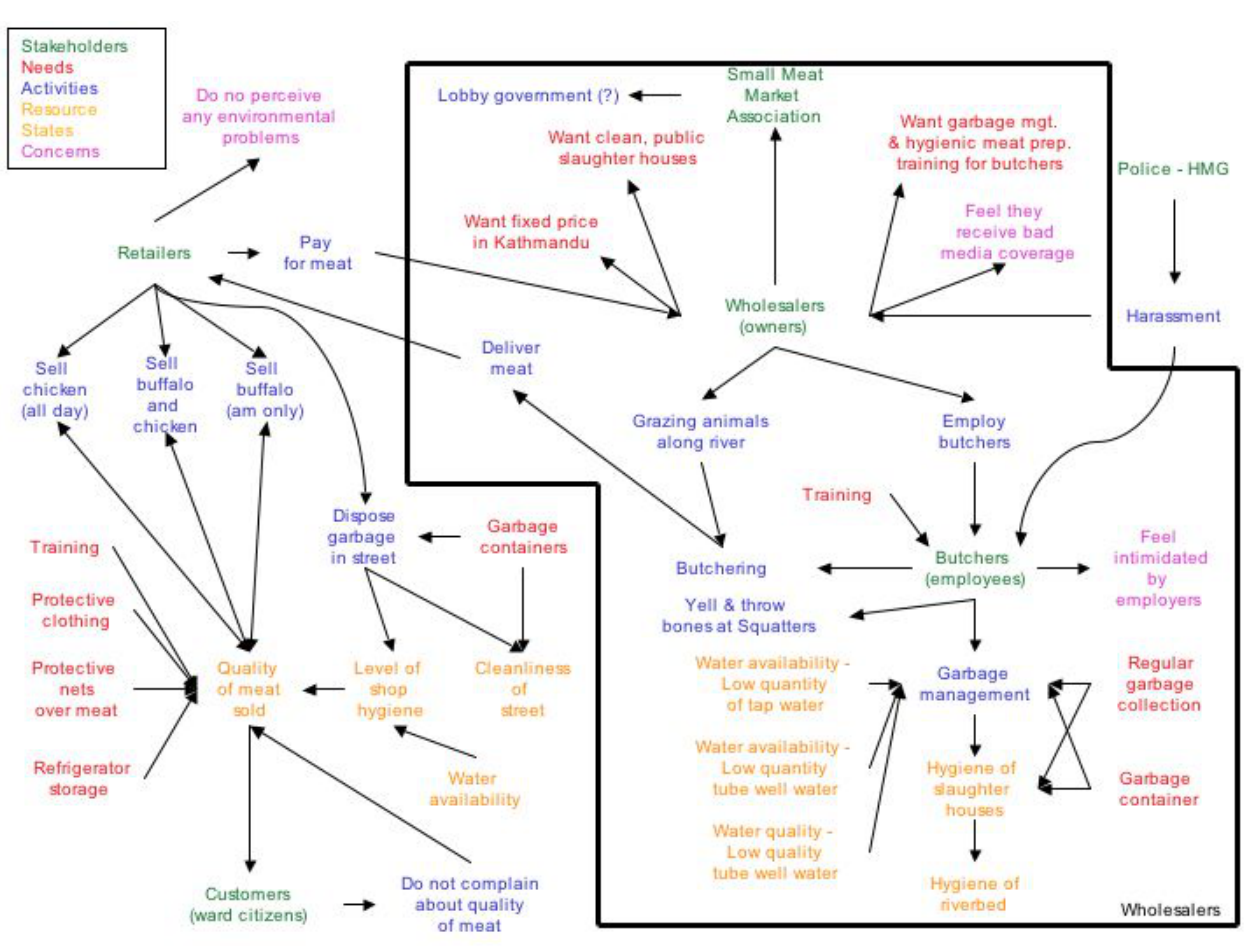
Fig. 5 . Issues and influences - butcher